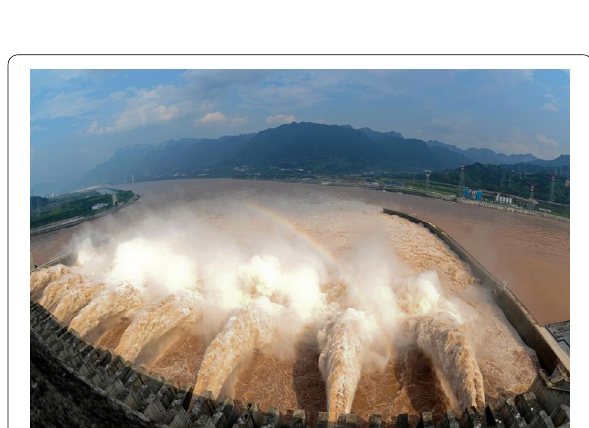
Fig. 13 The three gorges dam on the Yangtze River in Hubei, China (from http://www.rinno vabil